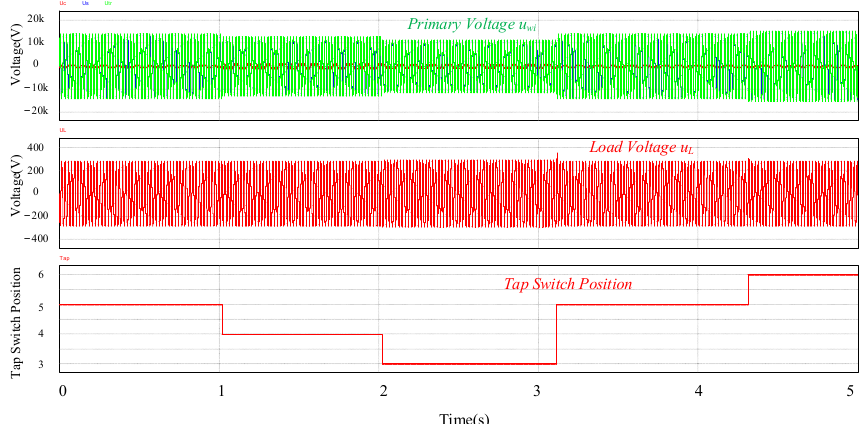
Figure 14. Waveform diagram of step-less voltage regulation of flexible OLVR under different volt- age fluctuation.